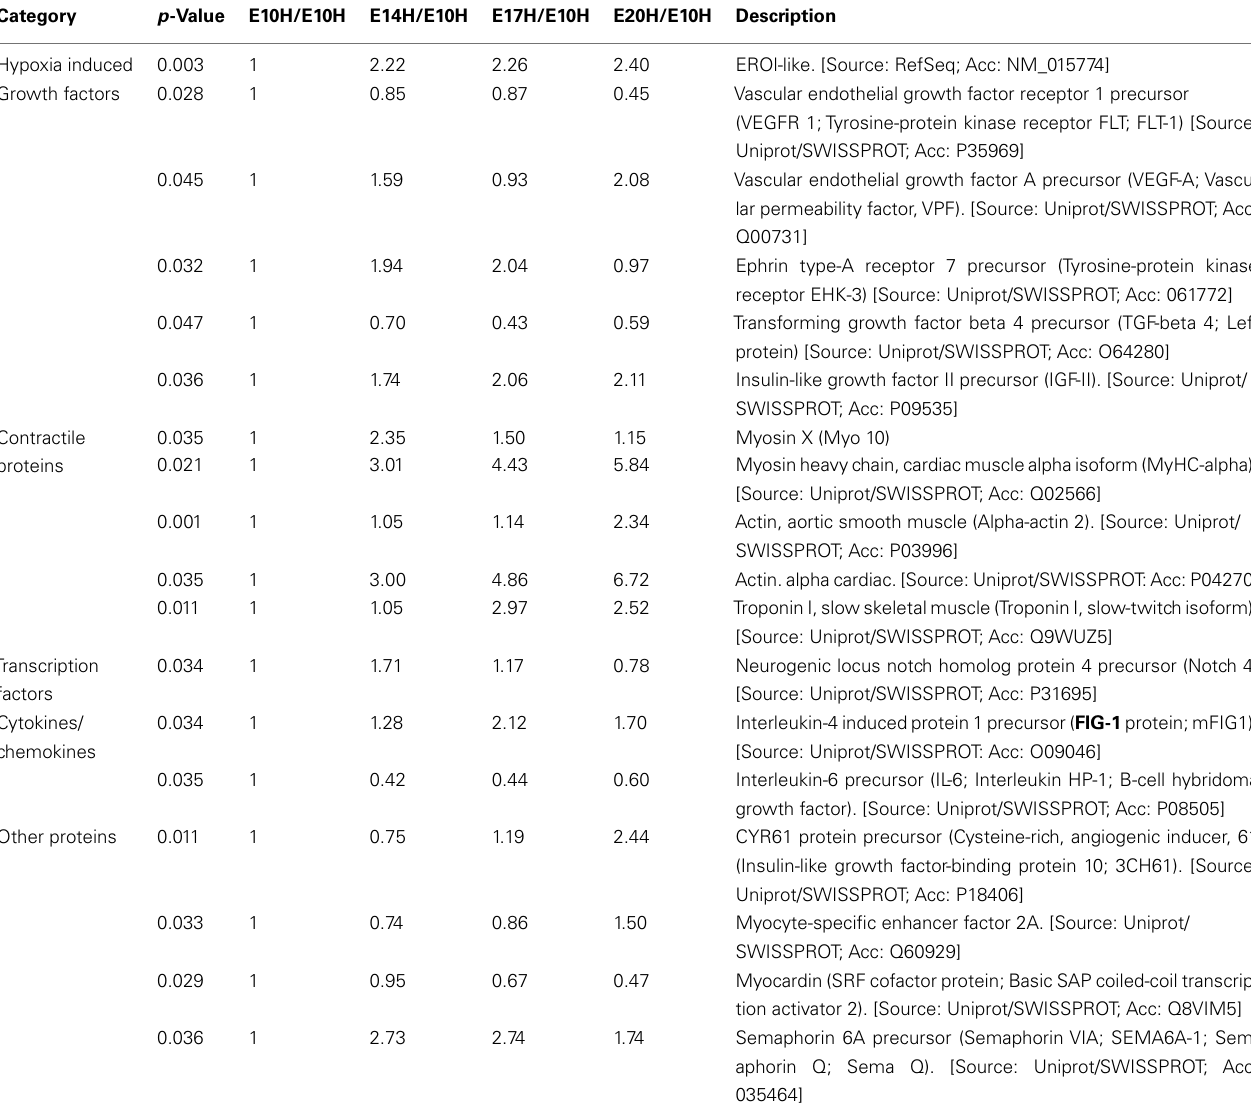
Table 2 | Microarray analysis of selected genes of interest from a total of 995 genes that are at least twofold up- or down-regulated ( p < 0.05; n = 3) across age namely E10–E20 when subjected to hypoxic treatment.